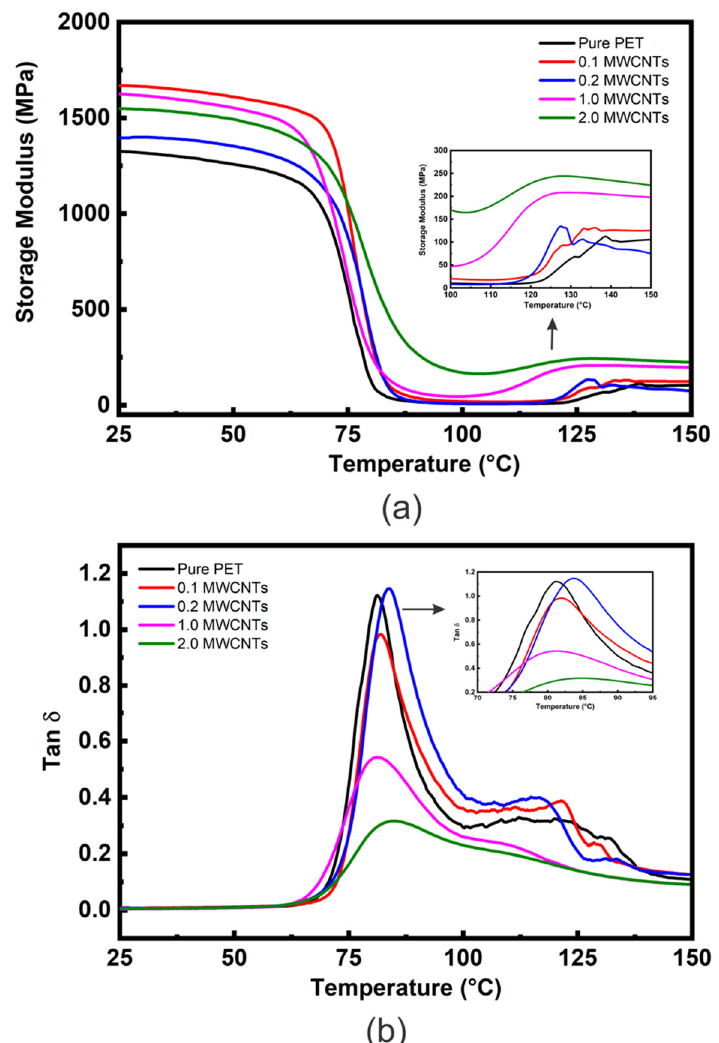
Figure 5. ( a ) DMTA E (cid:48) vs. temperature data and ( b ) DMTA tan δ vs. temperature data for the PET/MWCNT